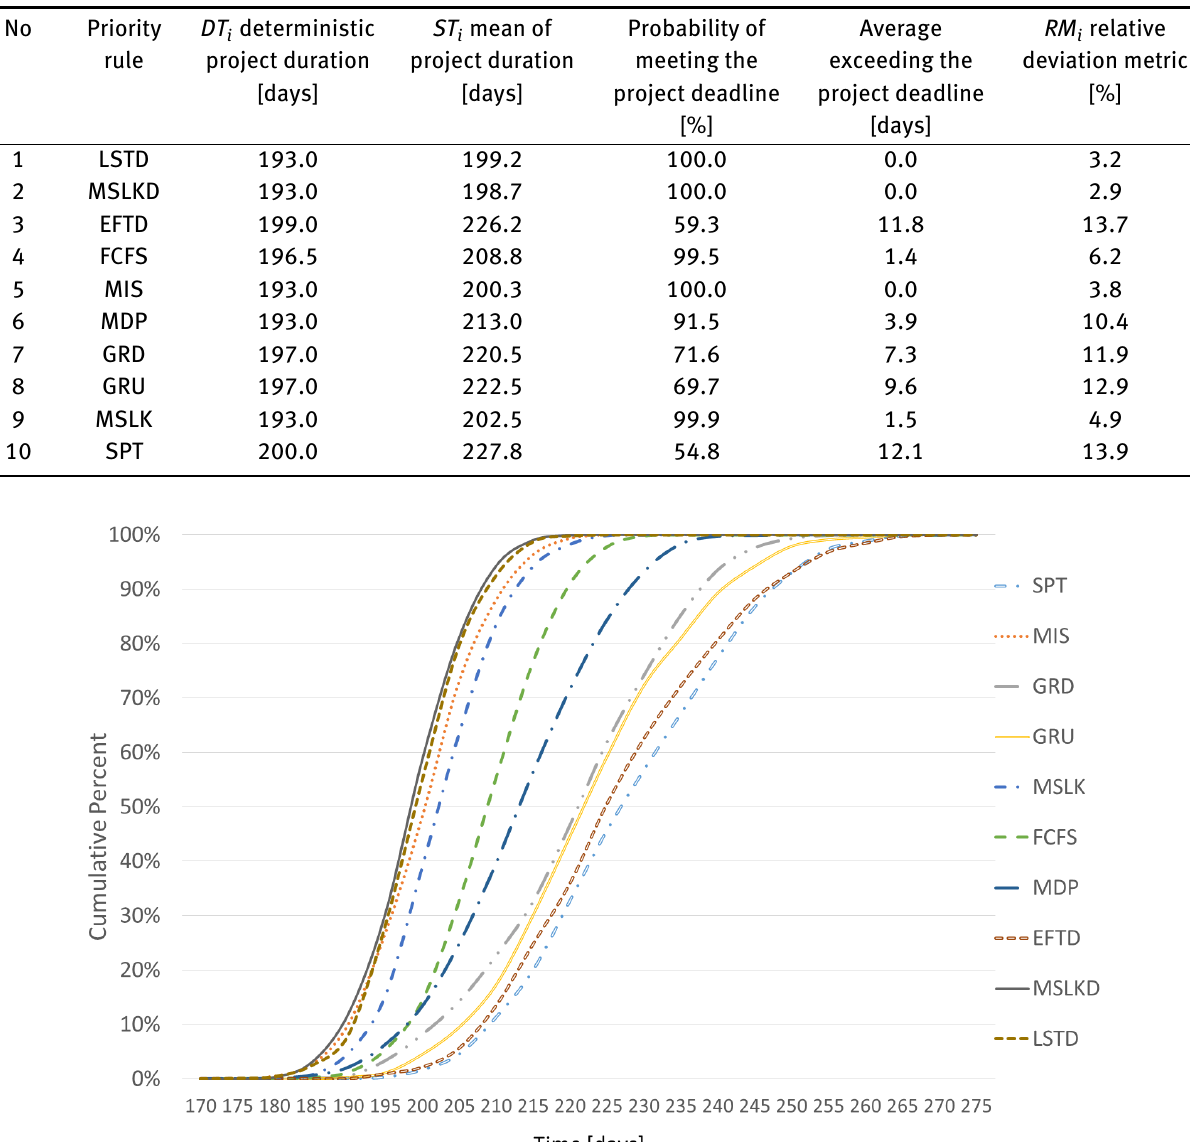
Table 2: Simulation results